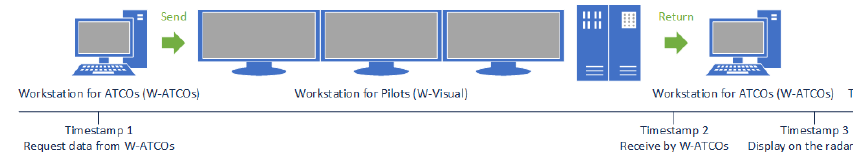
Figure 7. The measurement of latency. Table 2. Timestamp snapshotted for latency measurement.